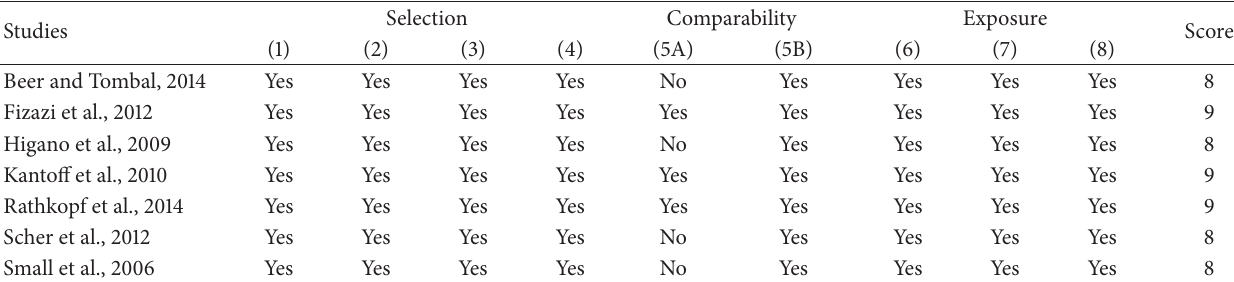
Table 1: Quality indicators by Newcastle-Ottawa